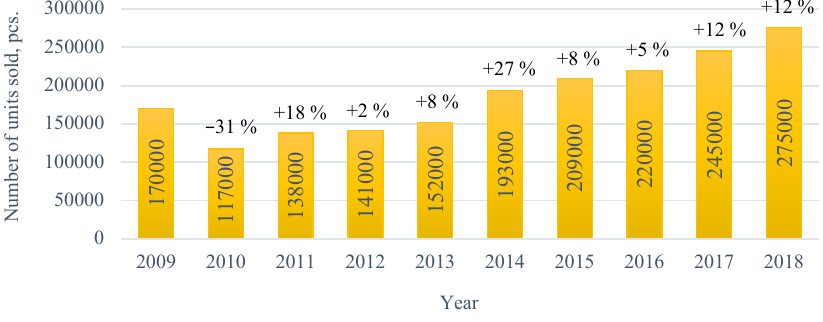
Fig. 5. The development of heat pump sales in